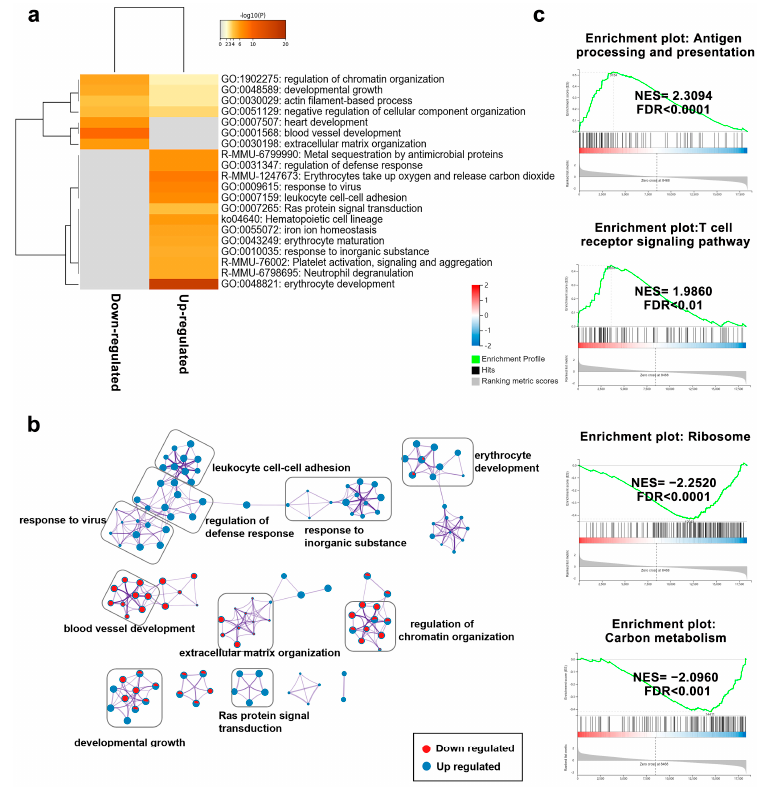
Figure 7. Effects of CBPA on gene expression signatures in tumor tissue. ( a ) Heatmap from Metascape analysis displaying the top enrichment pathways of down- and upregulated transcripts in MC38 tumor tissue excised from CBPA-treated (10 mg/kg, n = 3) group. Gray color indicates no significance. ( b ) Functional network analyses based on differentially expressed transcripts were performed using the Metascape database. Red/blue nodes indicate the terms with down-/upregulated transcripts, respectively. The sizes of the nodes show the significance of the enrichment results. ( c ) Plotting of the enriched KEGG pathways using GSEA.